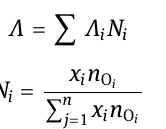
Table 4: Chemical composition of slags and metal after dephosphorization experiments at 1,550°C ( wt% )